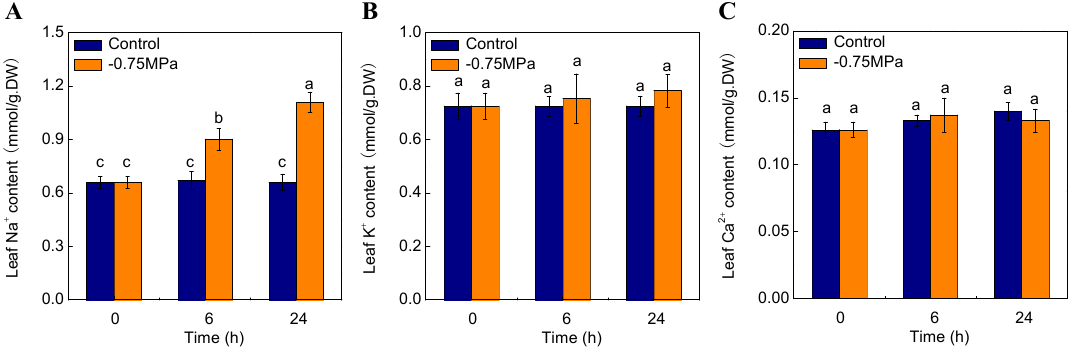
Figure 7. Effects of sorbitol treatment on Na + ( A ), K + ( B ) and Ca 2+ ( C ) content. Values are means and bars indicate SDs ( n = 6). Columns with different letters indicate significant difference by Duncan’s multiple range tests at p < 0.05.